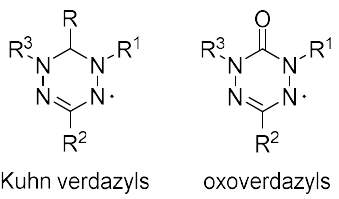
Figure 1. Structures of two types of verdazyls.